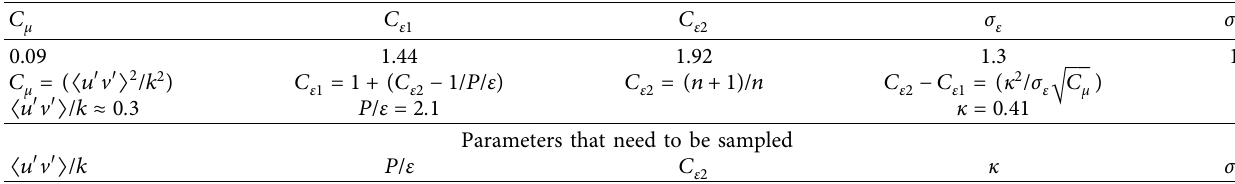
Table 1: Coefficients of k − ε